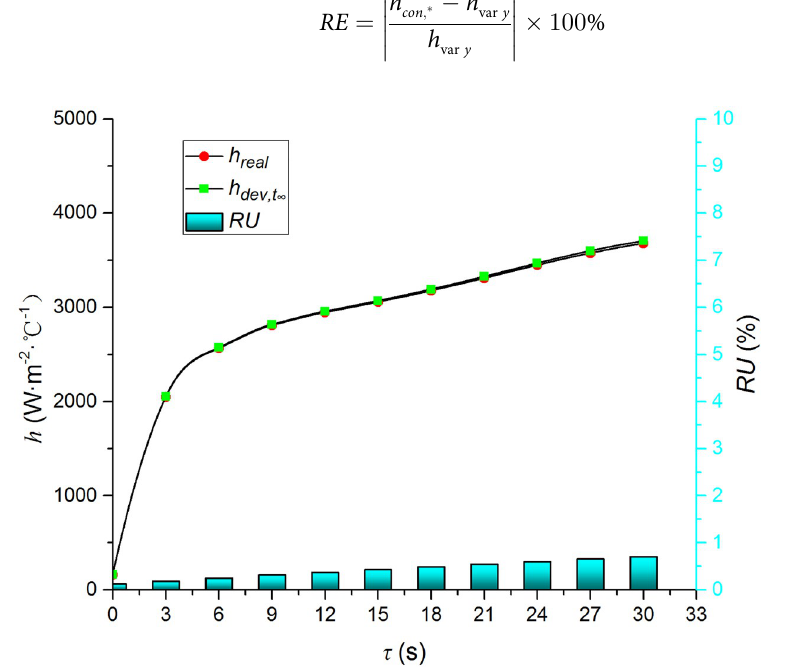
Fig 13. Comparison of h